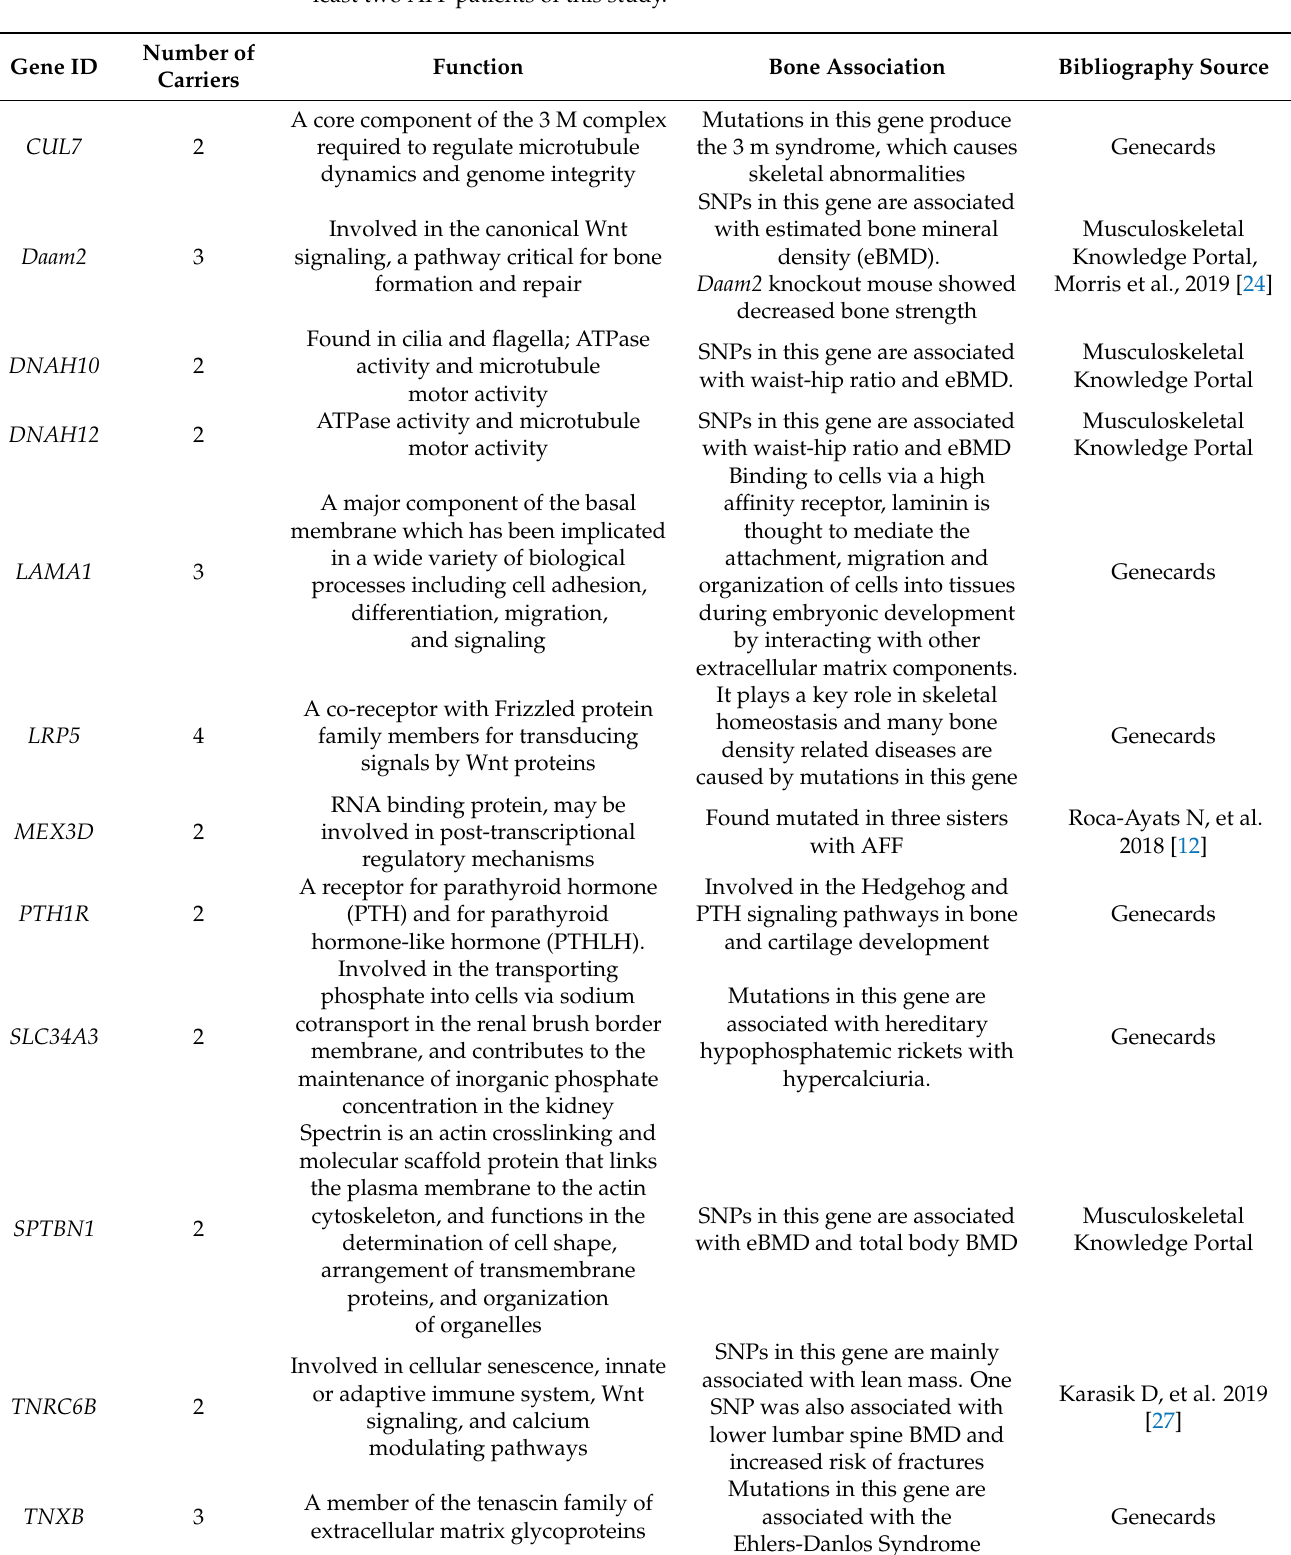
Table 3. Genes involved in bone metabolism and/or AFF containing deleterious rare variants in at least two AFF patients of this